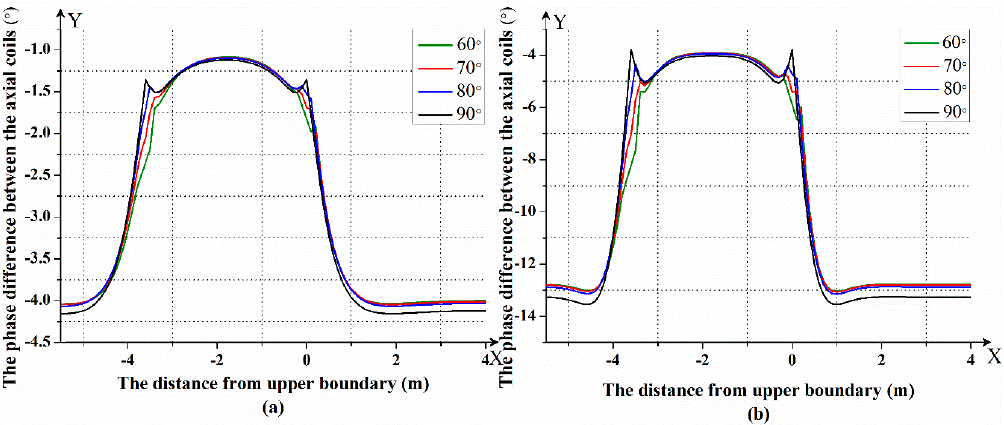
Figure 4. The phase difference between the axial receiving coils at a frequency of ( a ) 400 kHz and ( b ) 2 MHz.